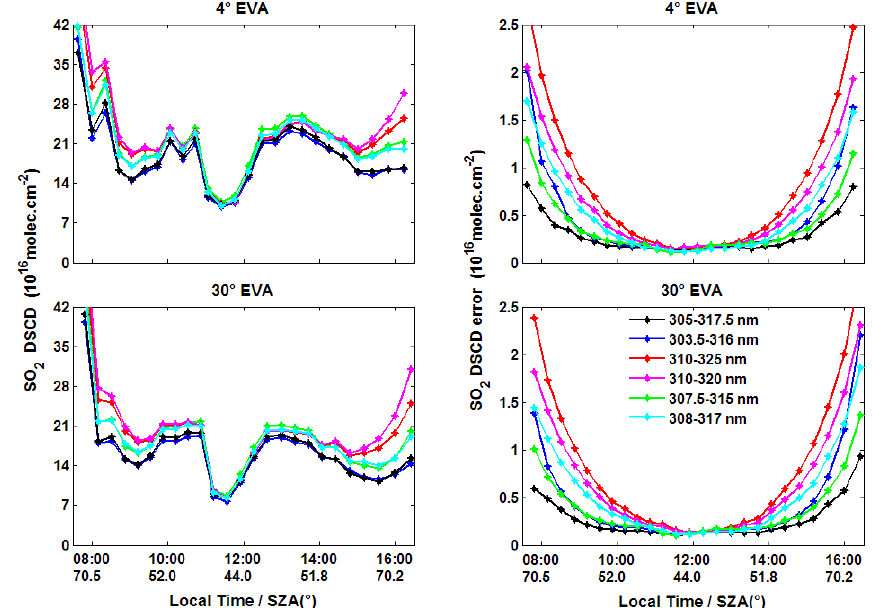
Figure 3. Same as Fig. 2, but for 4 October